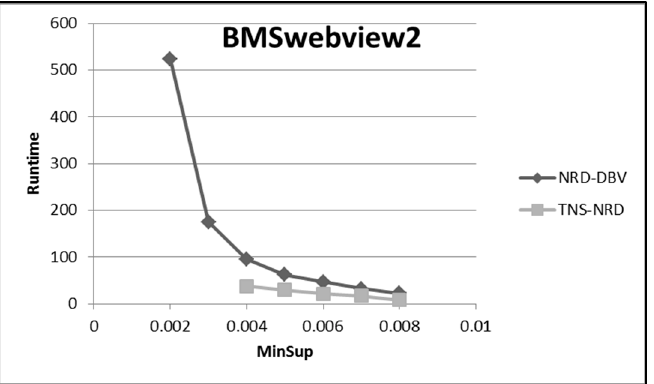
Figure 22. Comparison of the runtime of the TNS with the NRD-DBV for (BMS webview2) dataset.